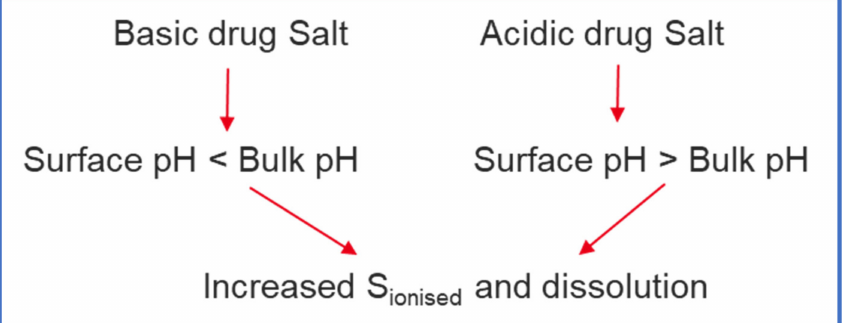
Figure 9. Effect of Surface pH on drugs formulated as salts (‘Salt